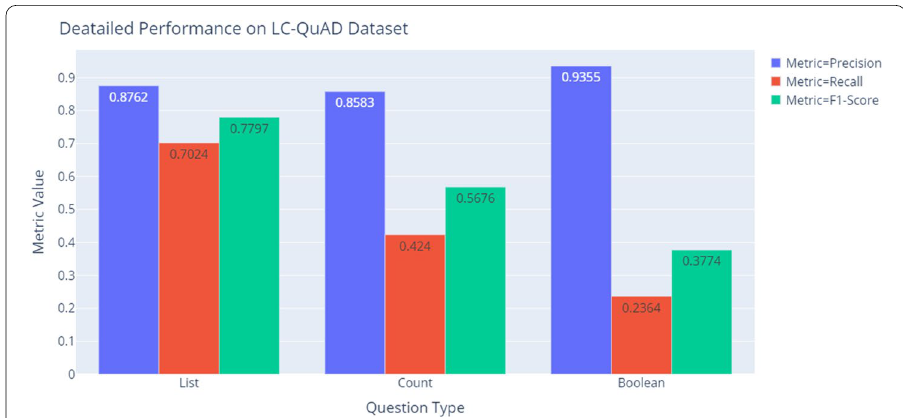
Fig. 7 Performance of each question type on LC-QuAD dataset